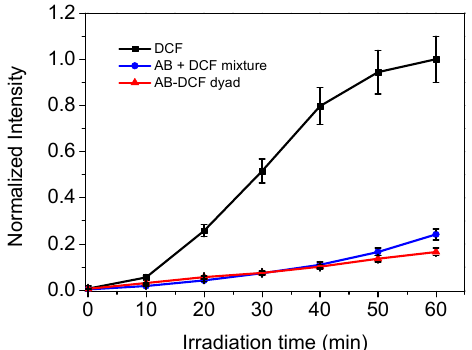
Figure 6. Time-course formation of carbazole-derived photoproducts followed by fluorescence, registering the emission intensity at 347 nm ( λ exc = 290 nm) for aerated solutions of DCF alone (black), the equimolar DCF+AB mixture (blue), and the AB-DCF dyad (red) in diethylene glycol.